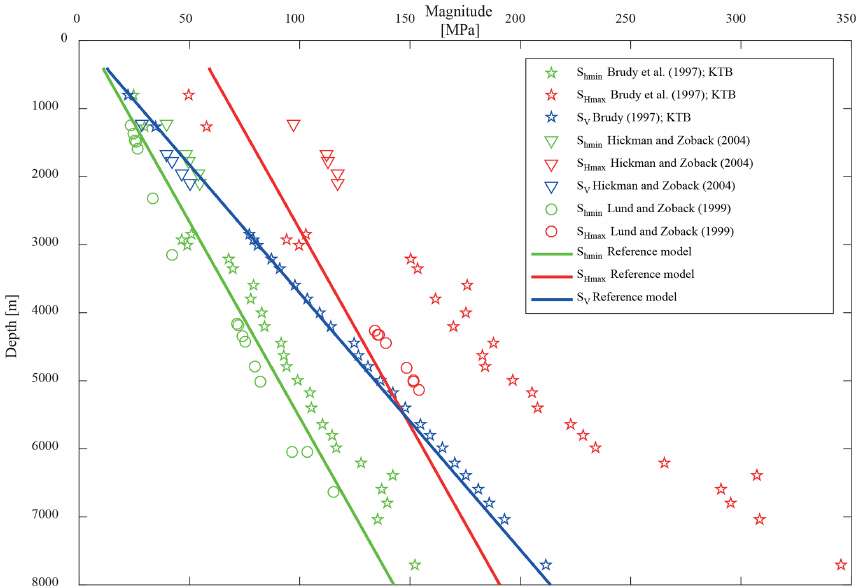
Figure 5. The stress magnitudes are plotted as a function of depth. The stress components from the virtual well in the model are illustrated by the coloured lines. The location of the virtual well and boundary conditions used are shown in Fig. 2. Due to the applied initial stress conditions, the stress regime changes from thrust faulting at a depth of 400m to strike slip faulting, and finally to a normal faulting regime at a depth greater than 5500m. Published stress magnitude data are shown for comparison (Brudy et al., 1997; Lund and Zoback, 1999; Hickman and Zoback, 2004).